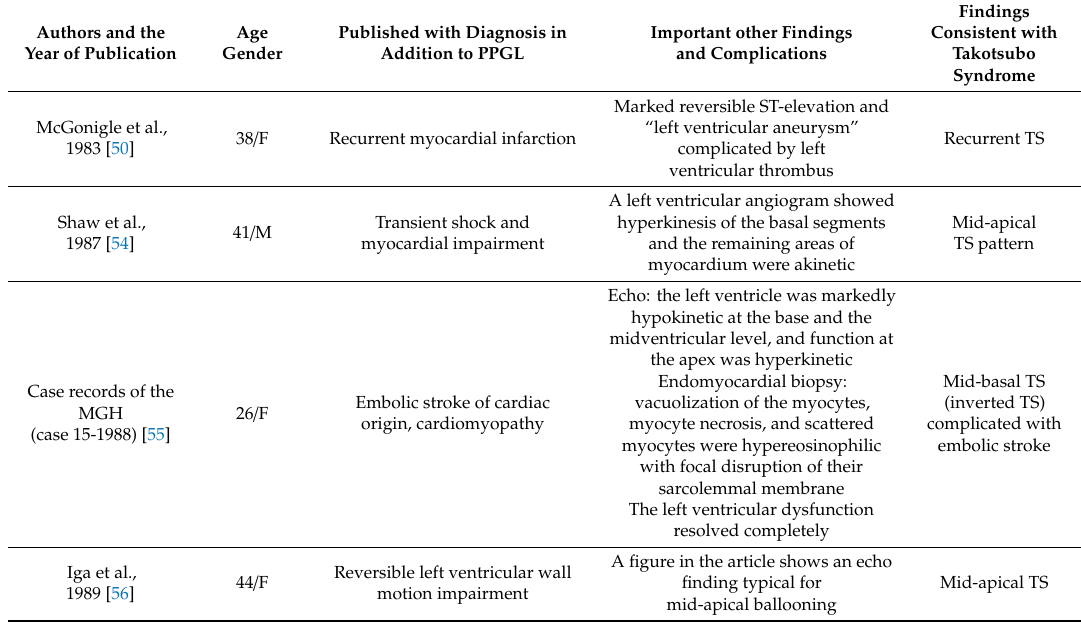
Figure 2. A case of recurrent takosubo syndrome (TS) induced by a pheochromocytoma. Contrast left ventriculography reveals mid-ventricular pattern of TS during the first episode ( A , diastole and B , systole). During recurrent TS 14 months after the first episode, echocardiography reveals typical mid-basal (inverted) pattern of TS ( C , diastole, and D , systole). Interestingly, the case was deemed as “type 2 myocardial infarction” during the first episode when pheochromocytoma was not diagnosed. Table 1. Published cases diagnosed with various pheochromocytomas and paragangliomas (PPGL)-induced cardiac complications but had features consistent with takotsubo syndrome.